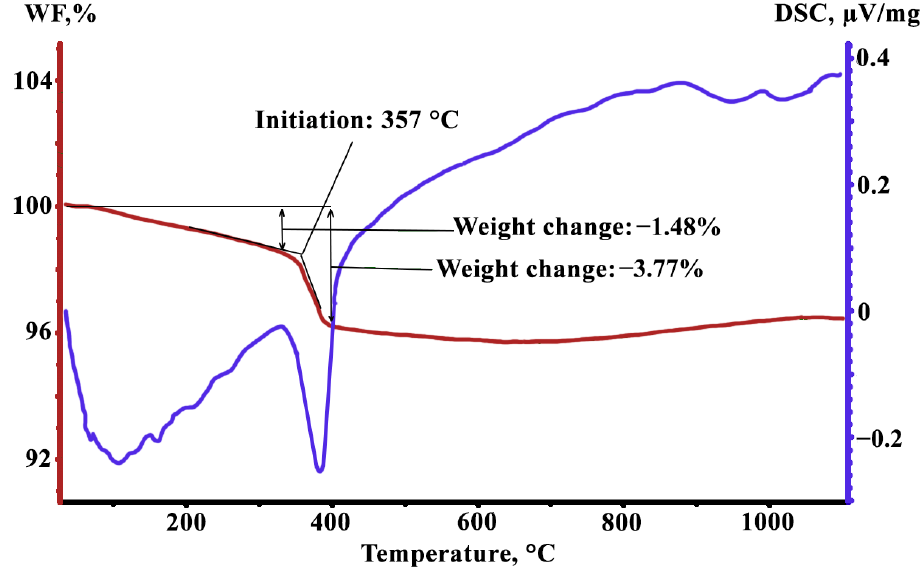
Figure 1. DSC of MgO + Mg(OH) 2 ·nH 2 O at a heating rate of 20°/min, WF — Weight